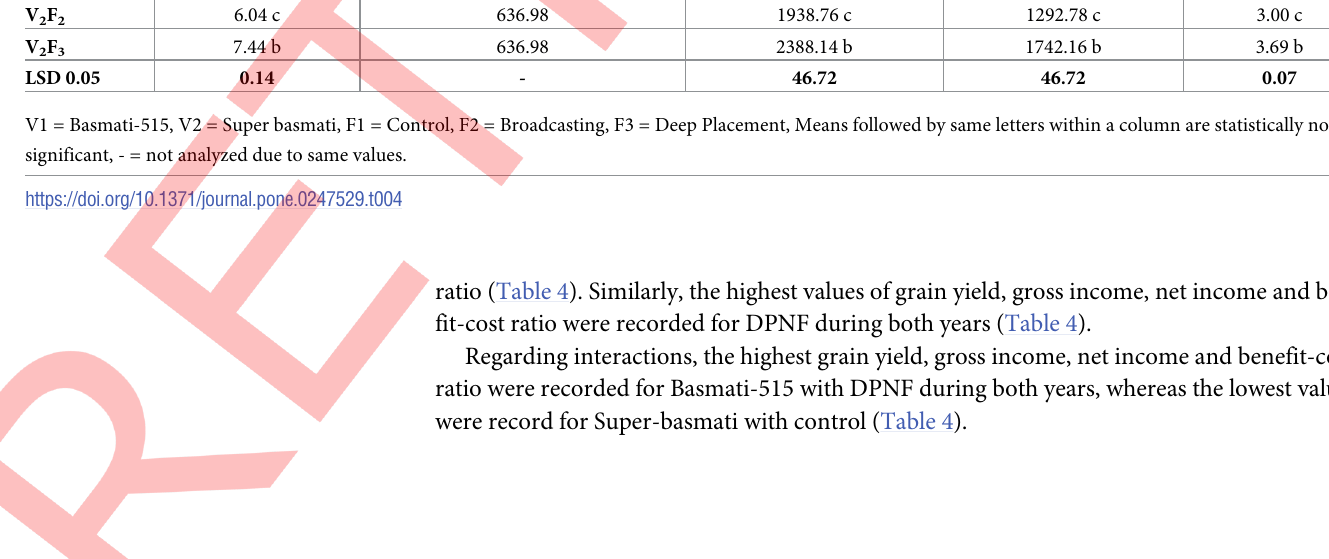
ratio (Table 4). Similarly, the highest values of grain yield, gross income, net income and bene- fit-cost ratio were recorded for DPNF during both years (Table 4). Regarding interactions, the highest grain yield, gross income, net income and benefit-cost ratio were recorded for Basmati-515 with DPNF during both years, whereas the lowest values were record for Super-basmati with control (Table 4).